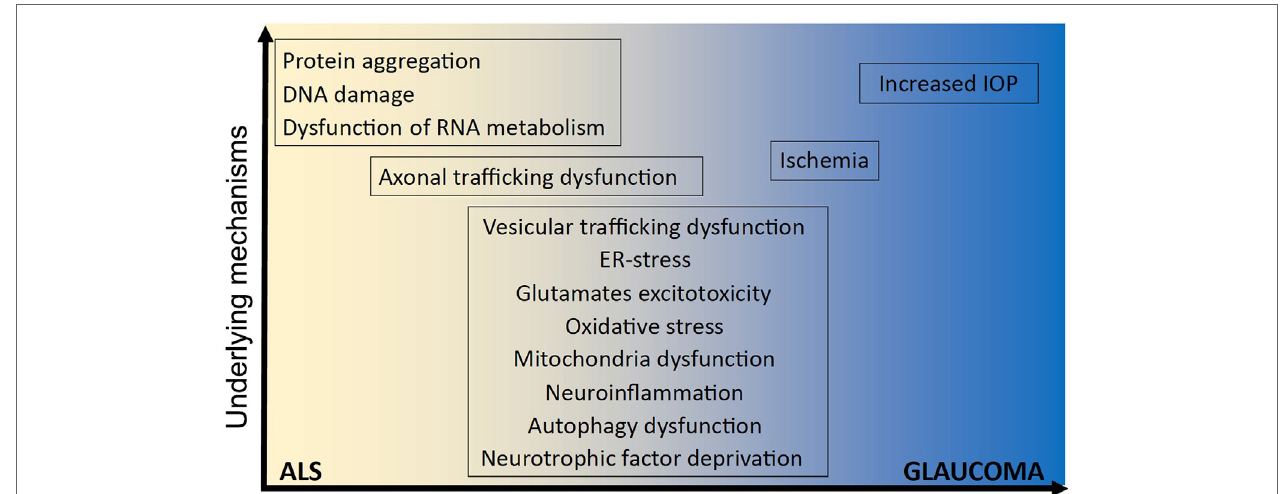
FiGURe 1 | Underlying mechanisms implicated in ALS and glaucoma. It remains unclear how optineurin mutations cause amyotrophic lateral sclerosis (ALS) and glaucoma and whether neurodegeneration involves mechanisms that are unique to one disorder or common to both. However, several shared cellular mechanisms have been implicated in both disorders, namely vesicular trafficking, endoplasmic reticulum (ER) stress, excitotoxicity, oxidative stress, mitochondria dysfunction, neuroinflammation, autophagy dysfunction, neurotrophic factor deprivation, axonal trafficking dysfunction, and ischemia. In contrast, other cellular processes have been implicated in either ALS; dysregulation of RNA metabolism, DNA damage, and protein aggregation; or glaucoma; increased intraocular pressure (IOP), and IOP; but not